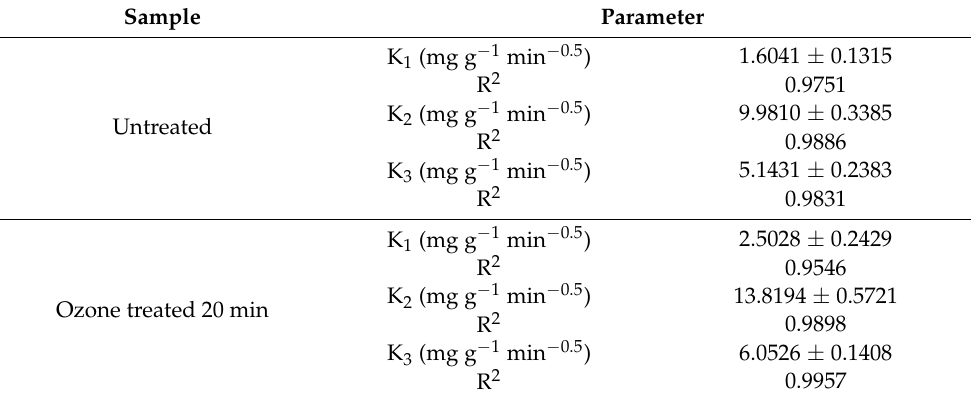
Table 7. Parameters of the intraparticle kinetic models together with its regression coefficients of adsorption data sample without treatment and 20 (cid:48) ozone